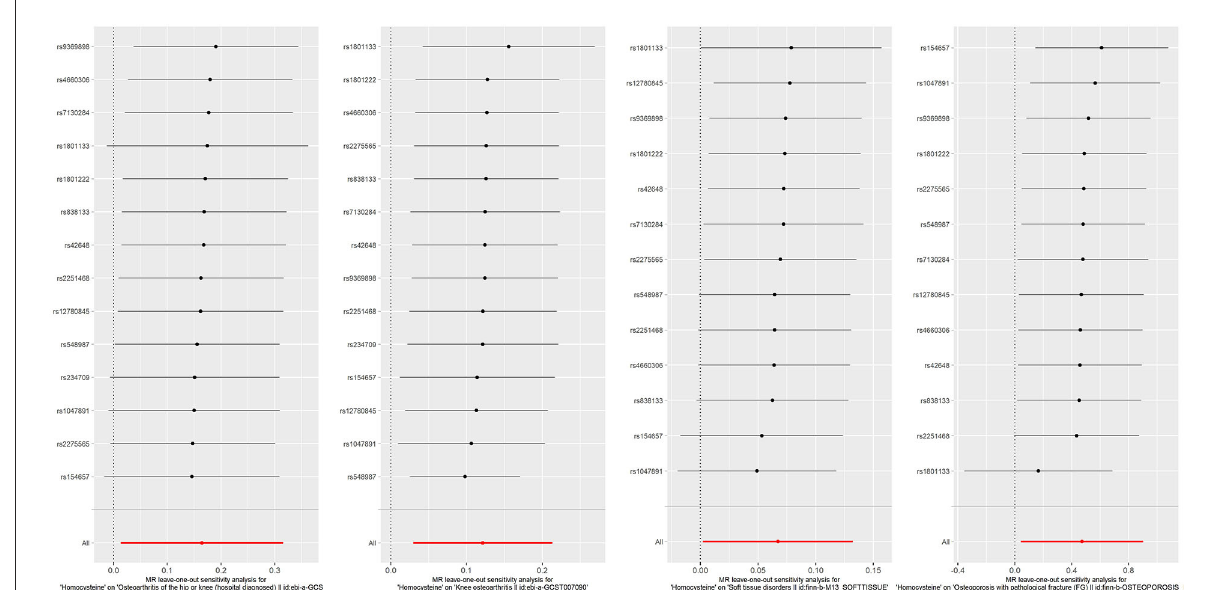
FIGURE6 Forest plot for leave-one-out analysis of the significant IVW results of homocysteine with soft tissue disorders, knee osteoarthritis, hospital-diagnosed osteoarthritis, and osteoporosis with pathological fracture, with each point denoting the causal effect by IVW after removing the specific SNP on the left side. IVW, inverse variance weighted method.